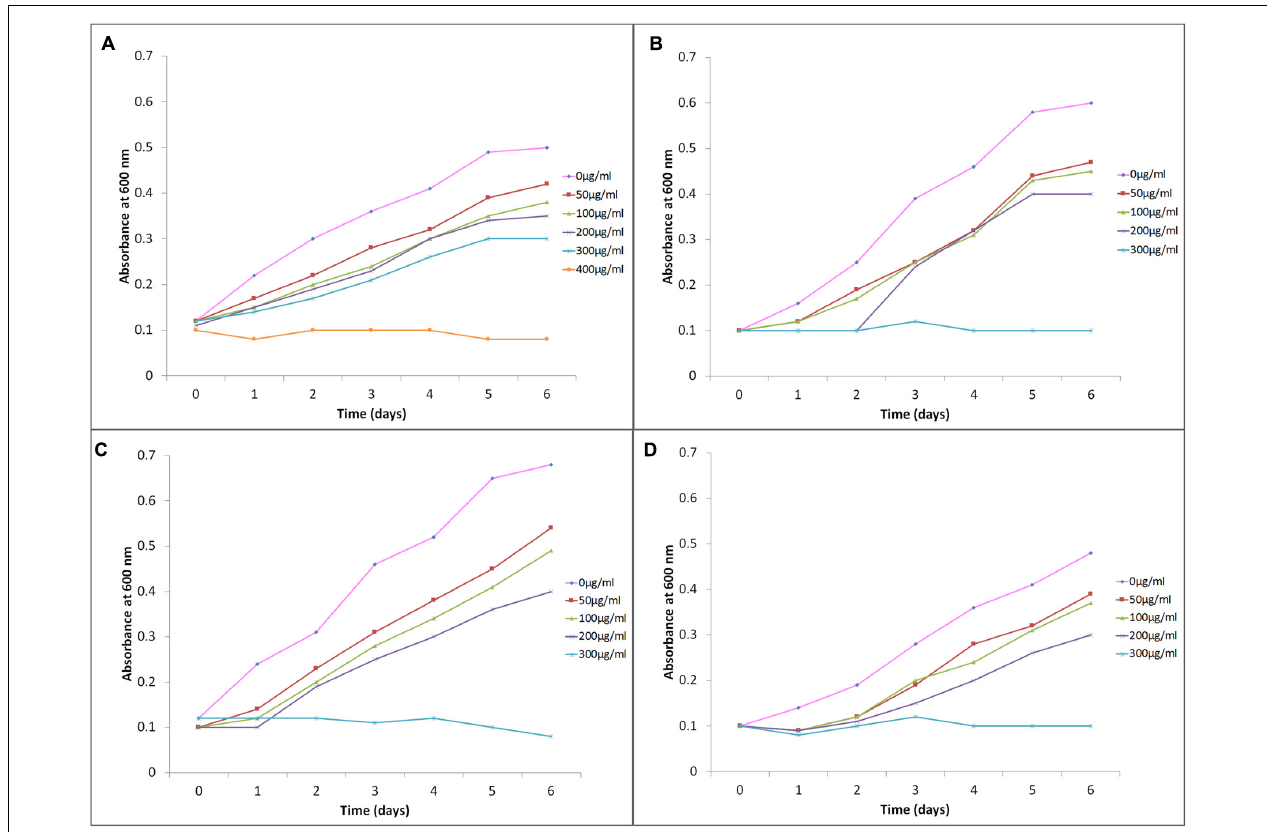
FIGURE 2 | Growth curve of Haloarchaea in different concentrations of SNPs: (A) Haloarcula argentinensis, (B) Haloarcula tradensis, (C) Haloferax lucentense , and (D) Haloferax